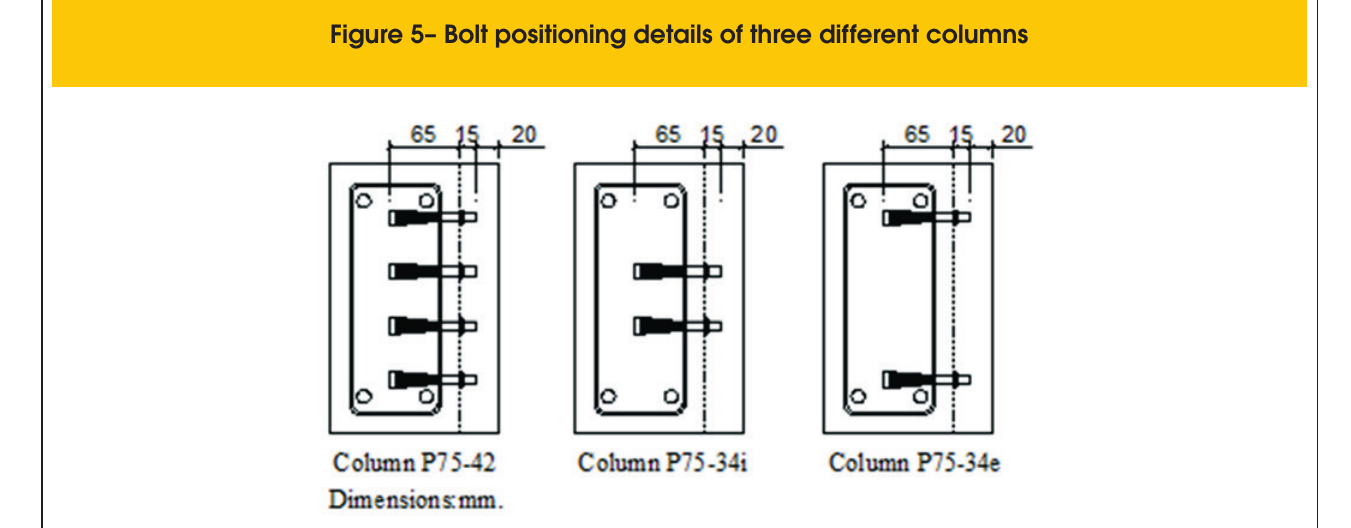
Figure 5– Bolt positioning details of three different